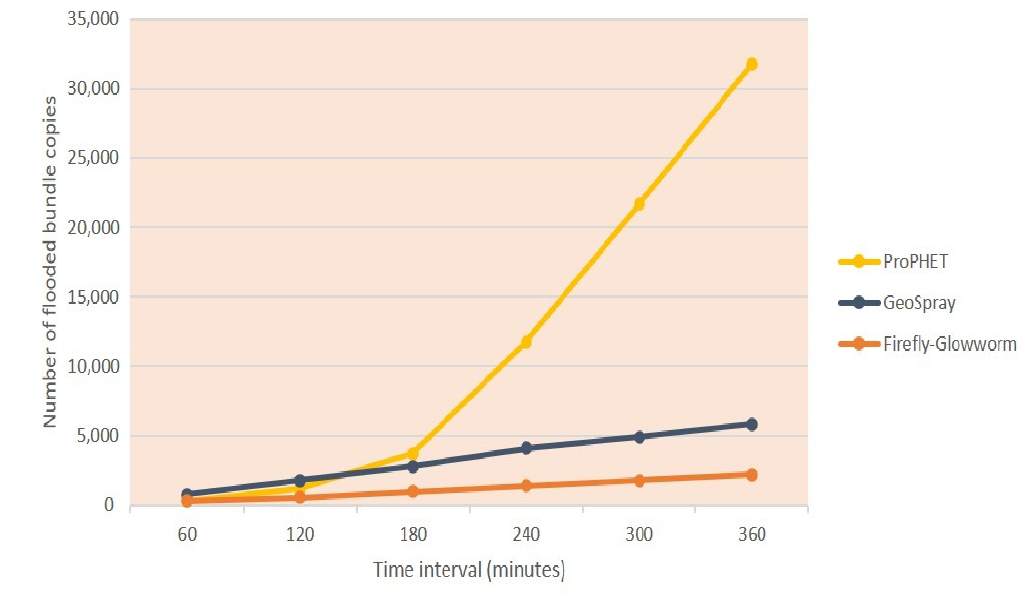
Figure 7. Number of flooded bundle